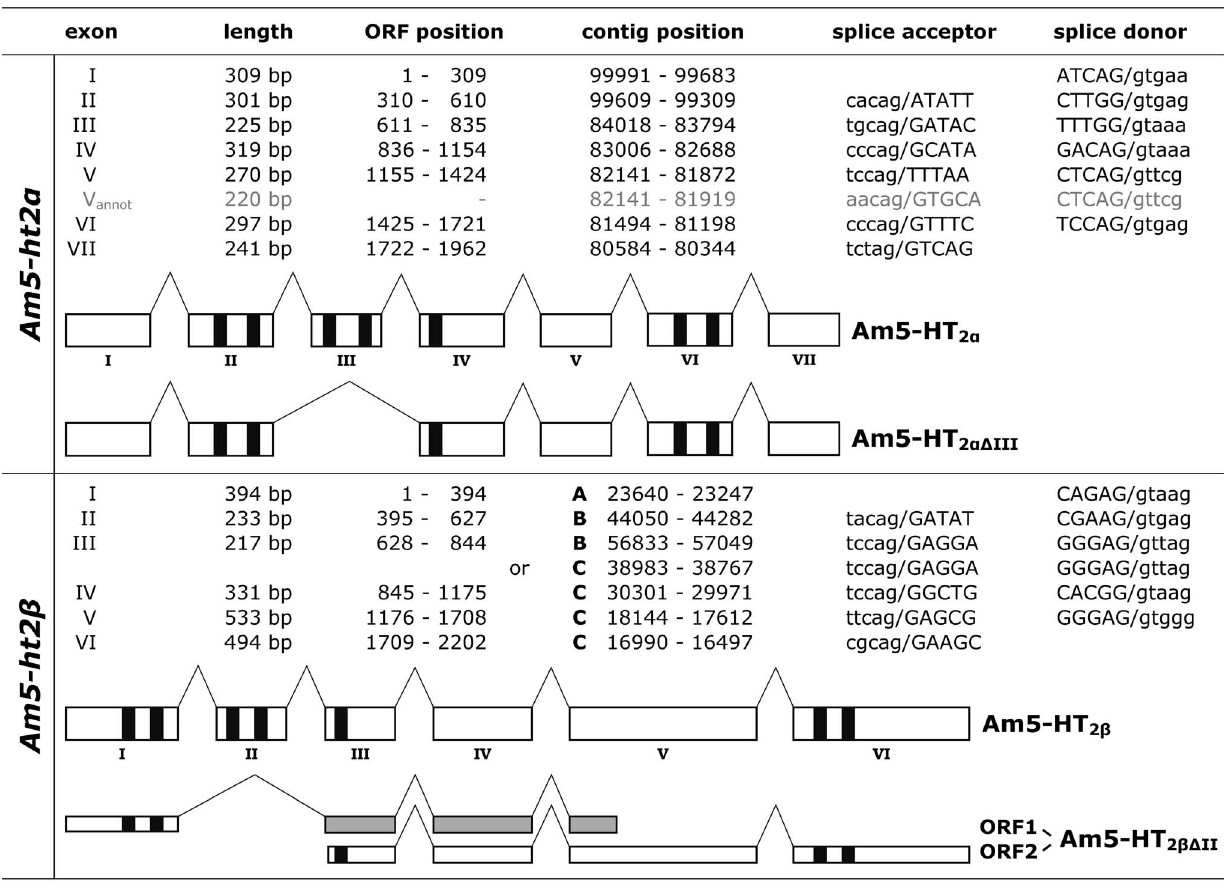
Figure 1. Genomic organization of Am5-ht2 a and Am5-ht2 b genes. The Apis mellifera genomic database (Amel_4.5) was screened with the Am5-ht2 a and Am5-ht2 b cDNA sequences. The figure shows the splicing pattern of the Am5-ht2 a (upper part) and Am5-ht2 b (lower part) genes. Nucleotide sequences of exons are given in upper-case letters and nucleotide sequences of introns are given in lower-case letters. Full-length and truncated receptor variants are displayed schematically. Boxes represent exons, and bent lines represent introns. The position of the seven trans- membrane domains is highlighted by black bars. Exons containing a frameshift are indicated in gray. The seven exons of the Am5-ht2 a gene are completely covered in the genomic contig NW_001253562. The six exons of the Am5-ht2 b gene are dispersed in three genomic contigs (A: NW_001262451, B: NW_001252966, und C: NW_001262048).